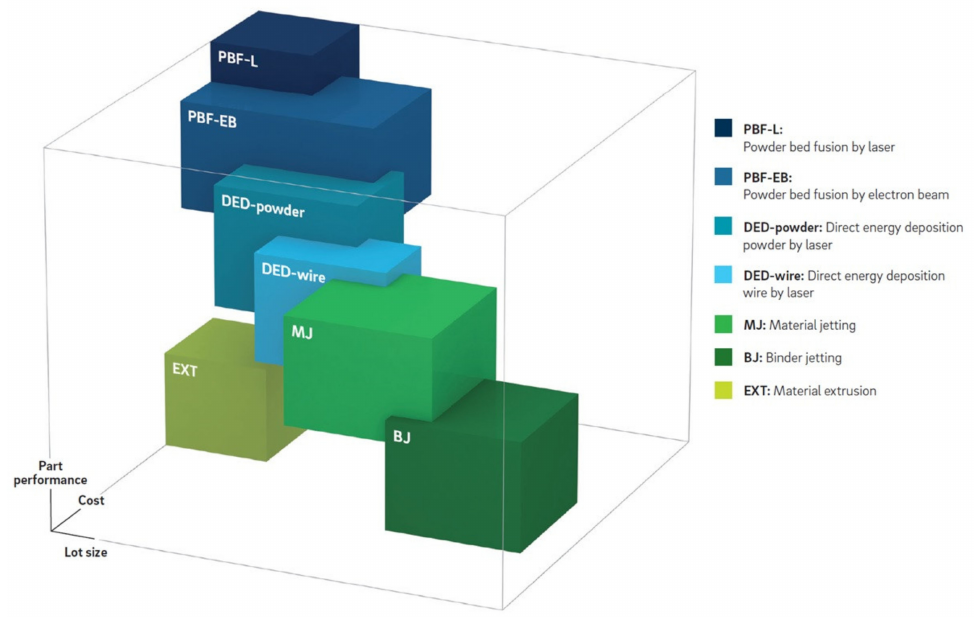
Figure 33. A 2018 comparison of different metal AM methods with respect to part performance, cost and lot size [32].